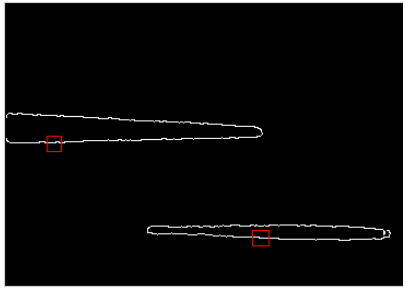
Figure 13. Single sensitive region on each defect is randomly selected.